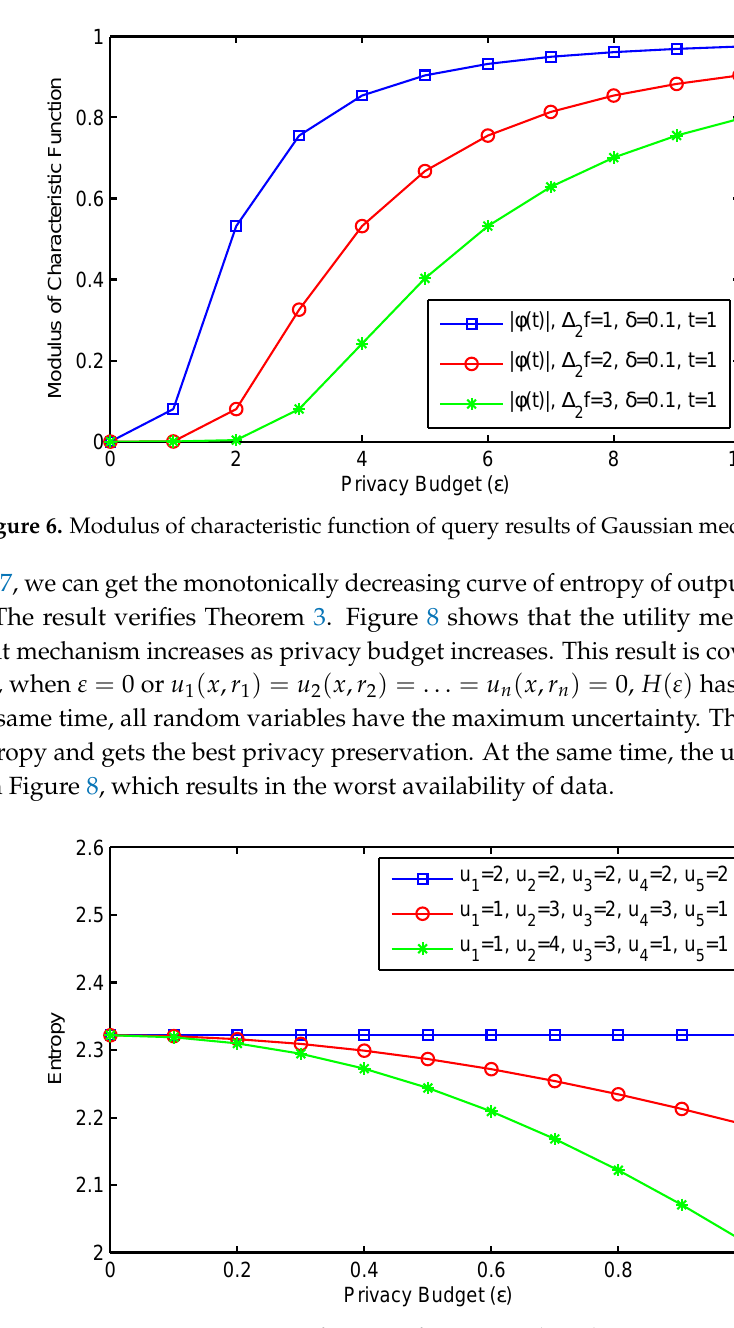
Figure 7. Entropy of output of exponential